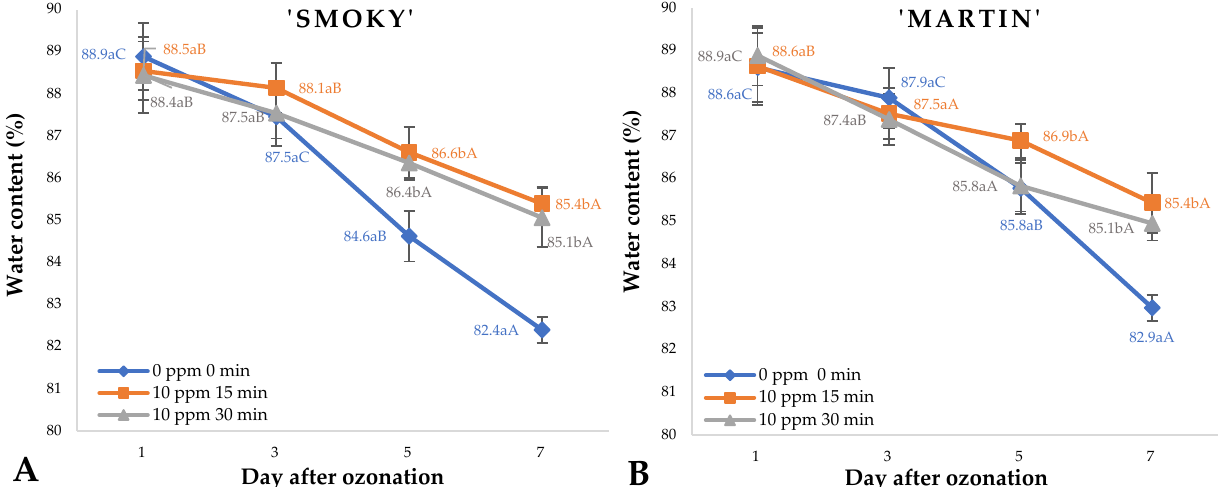
Figure 1. Water content and standard error of the means ( %) in saskatoon berries of ‘Smoky’ ( A ) and ‘Martin’ ( B ) cultivars, relative to the dose of ozone ( n = 3). Note: Differences in results between the dose of ozone on the specific days are indicated by different small letters, and differences between assessment days are indicated by different capital letters. Significance level at p < 0.05.